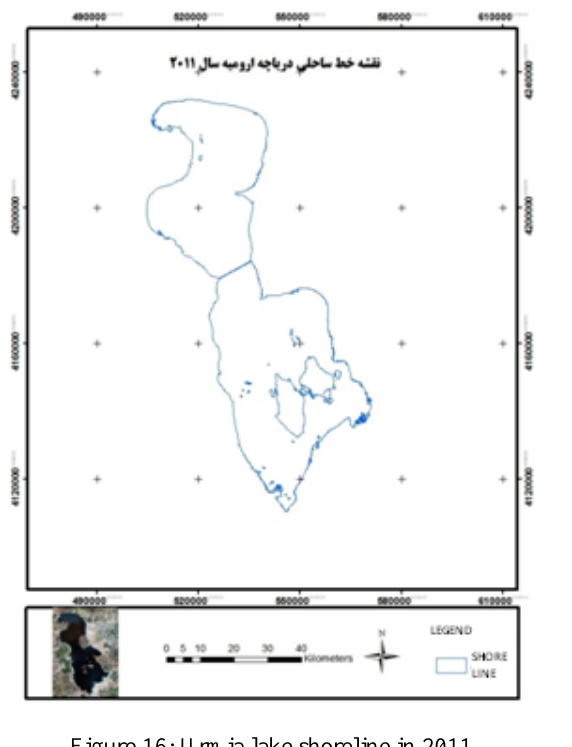
Figure 16: Urmia lake shoreline in 2011